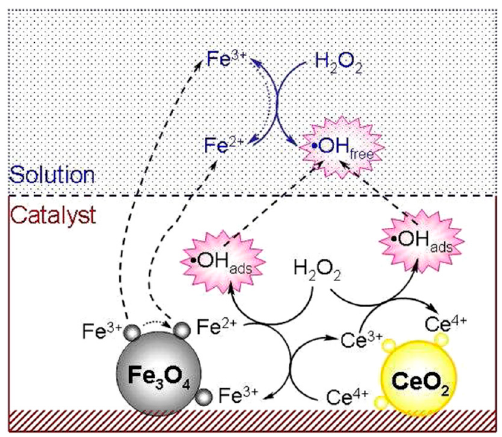
Figure 25. Proposed reaction mechanism of the H 2 O 2 activation by Fe 3 O 4 /CeO 2 catalyst under acidic pH. (Reprinted with permission from [158] . Copyright © 2012, American Chemical Society).